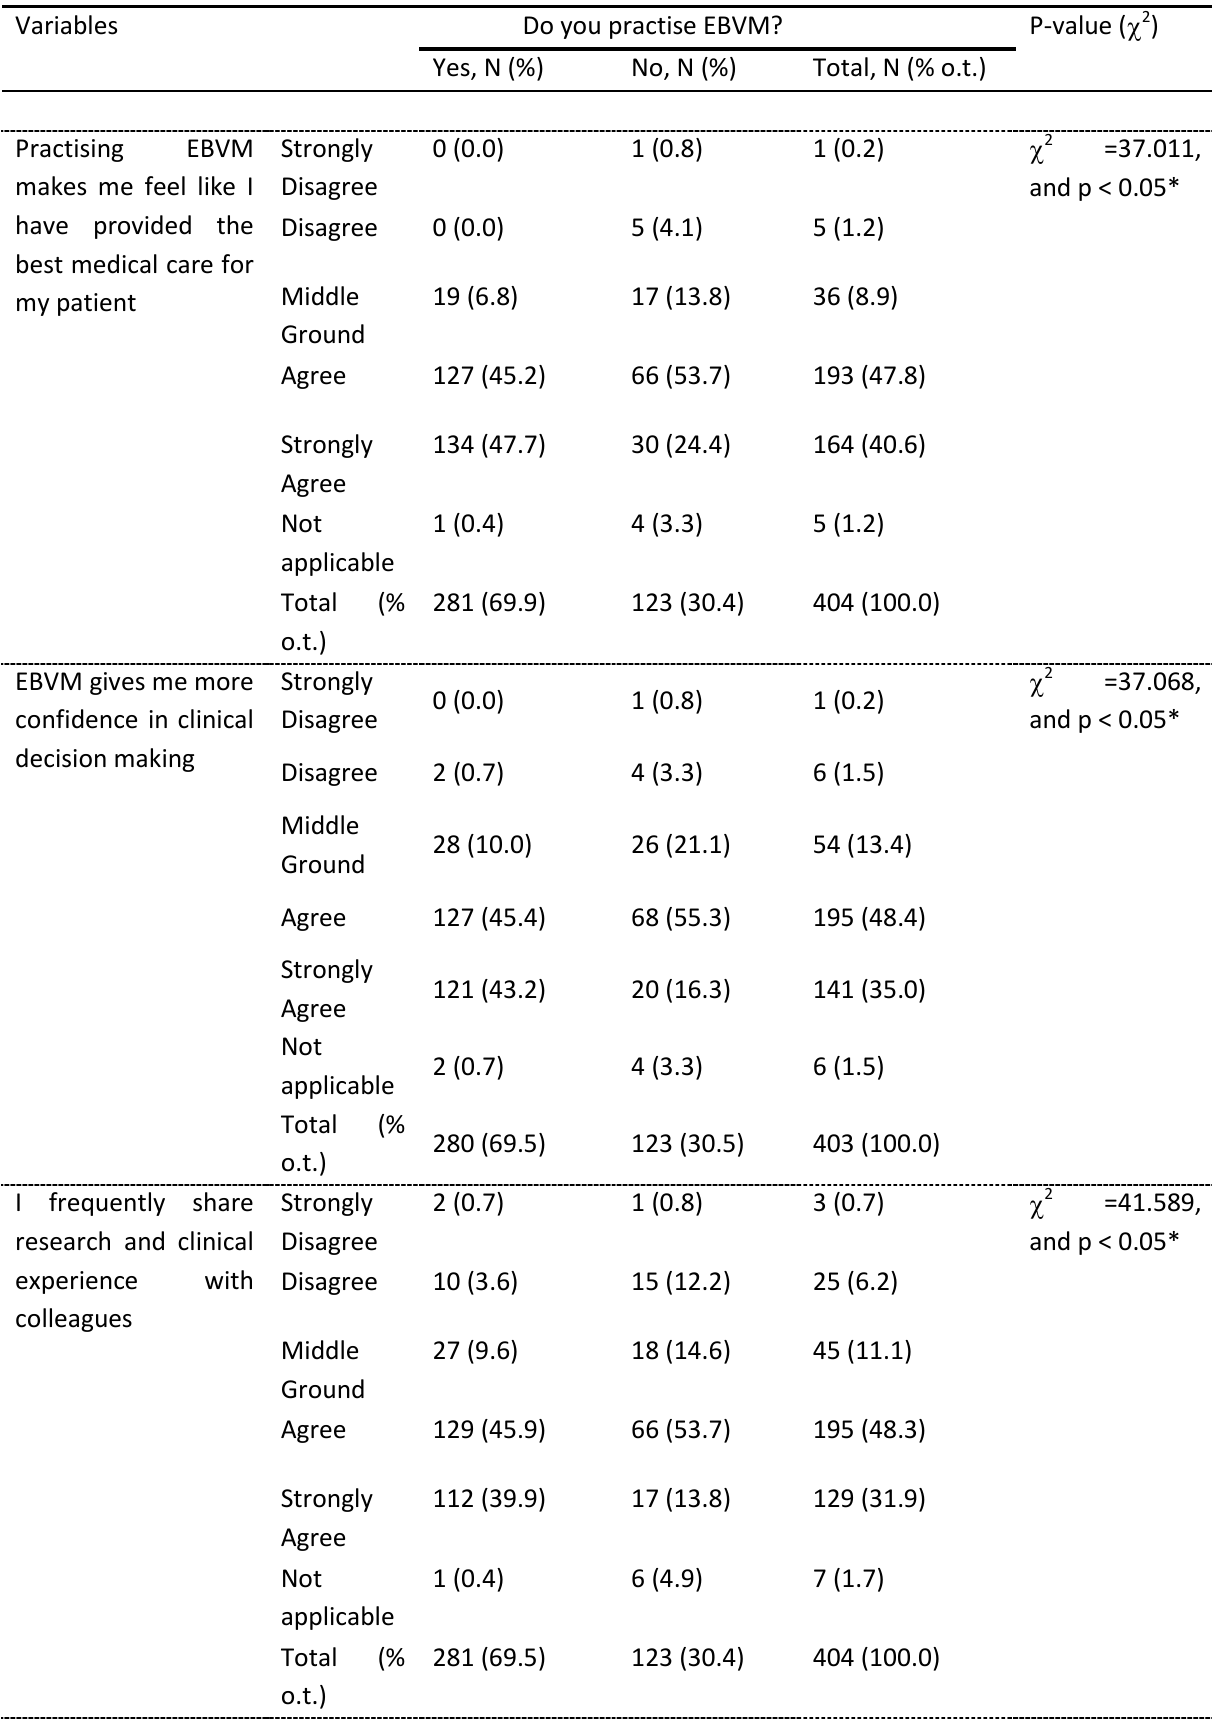
Table 7 : EBVM and employee engagement Variables Do you practise EBVM? P-value (  2 )